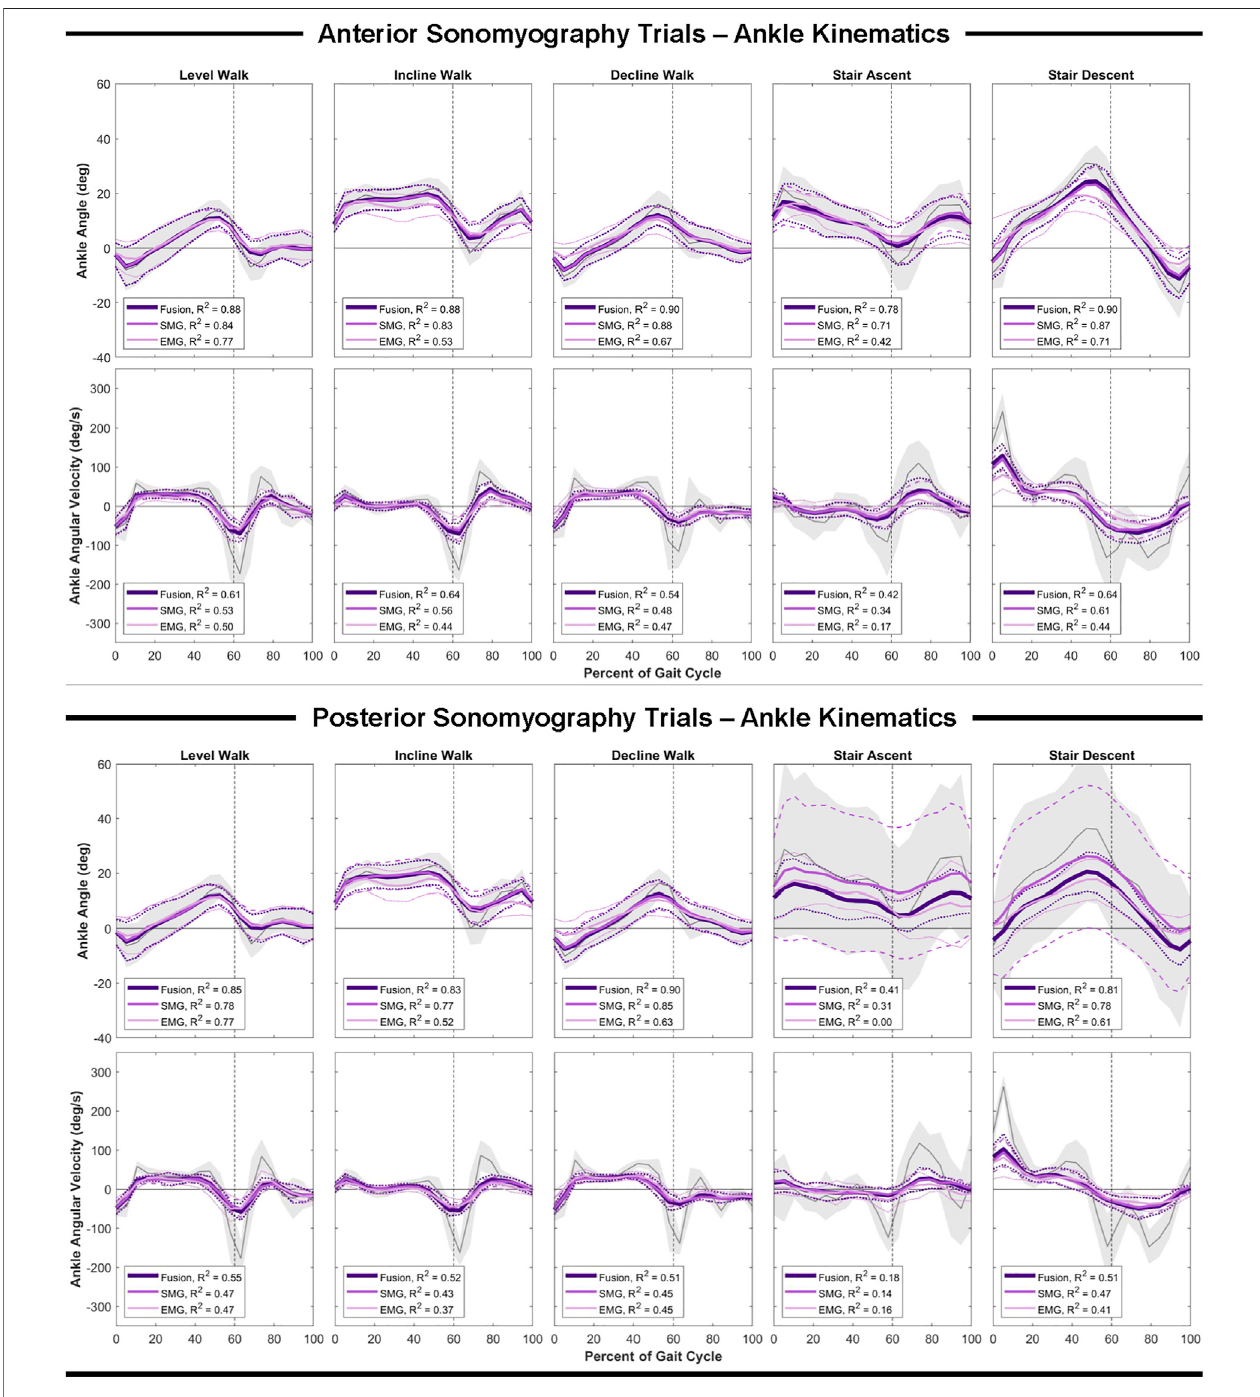
FIGURE 6 | Ankle angle and angular velocity as afunction of the gait cycle. Measured kinematics are displayed in gray with standard deviations in shaded regions. PredictedkinematicsfromGaussianprocessregressionmodelstrainedandtestedonfeaturesfromelectromyography(EMG),sonomyography(SMG)andsensorfusion (Fusion) are displayed with respective standard deviations. Adjusted R 2 given as a goodness-of- fi t metric for each sensing modality compared to the measured kinematics.